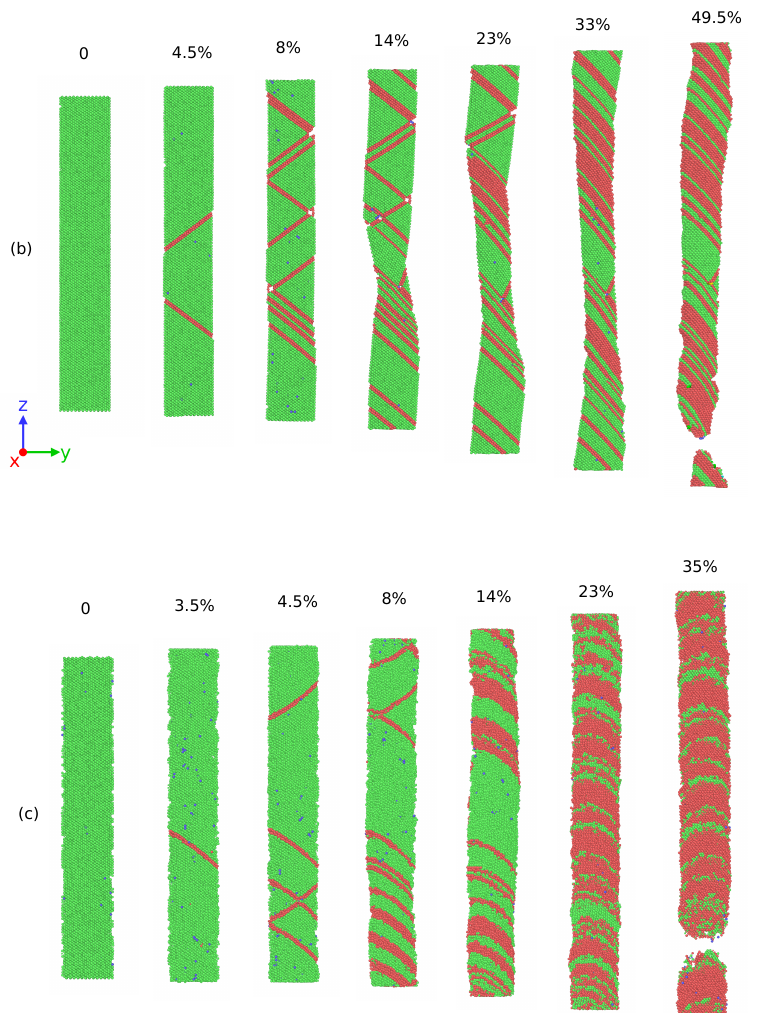
Figure 5. Atomic snapshots showing deformation behavior of single crystal HEA nanowires at ( a ) 77 K, reorientation from (110) to (100) phase begins after nucleation and glide of twin boundaries at 8% strain onwards. Complicated dislocation interaction is visible during deformation (see also animation S1 and S2 in the supplementary information); ( b ) 300 K; and ( c ) 1000 K. The percentage indicates the value of applied uniaxial strain in the Z